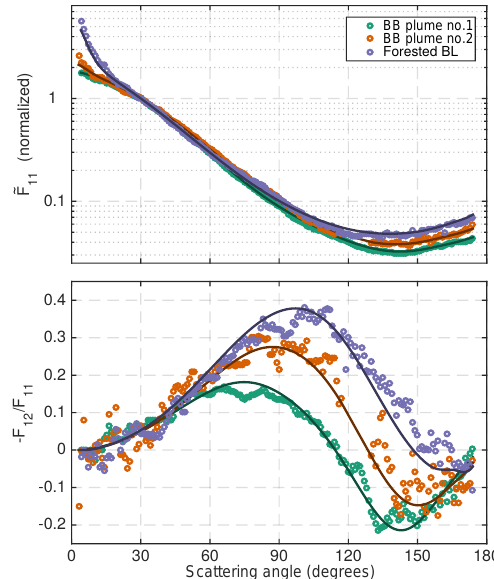
Figure 5. Normalized scattering matrix elements (circles) measured by the PI-Neph at 532nm and the corresponding GRASP fits (solid lines) for the three highlighted SEAC 4 RS aerosol